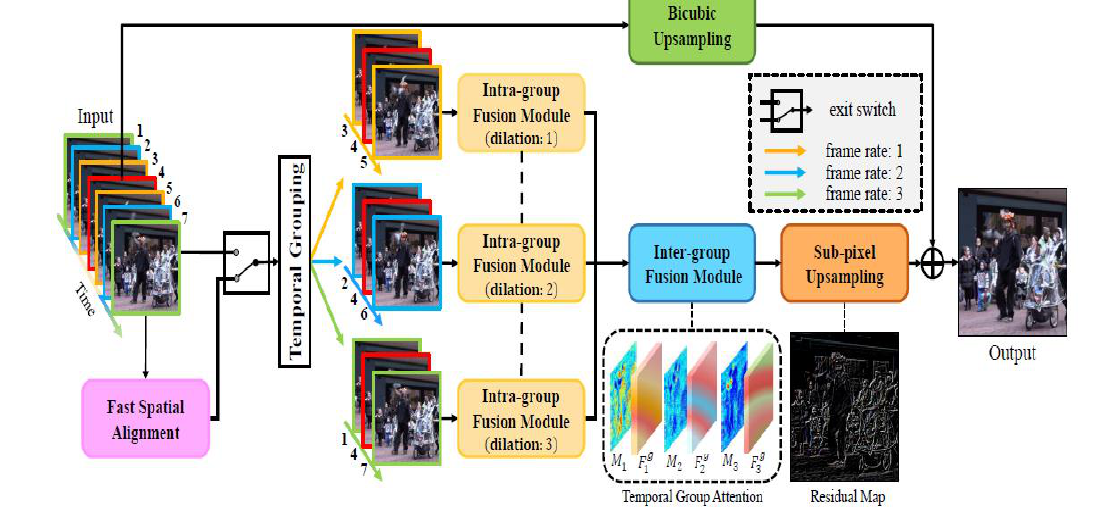
Figure 3. Sketch map of TGA (Isobe et al.,